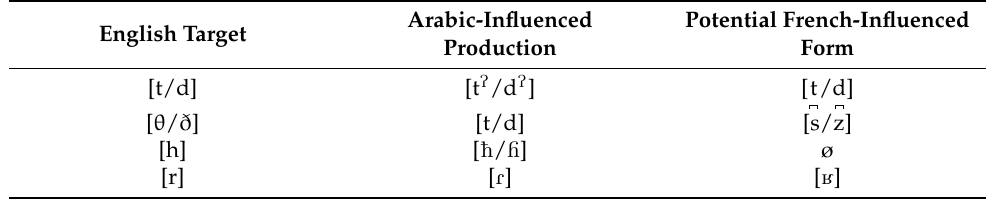
Table 3. Segmental properties of the L3 English.